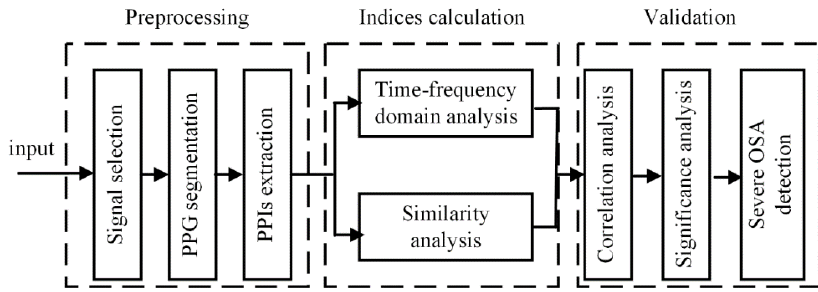
Figure 2. The framework of proposed PRV analysis method.